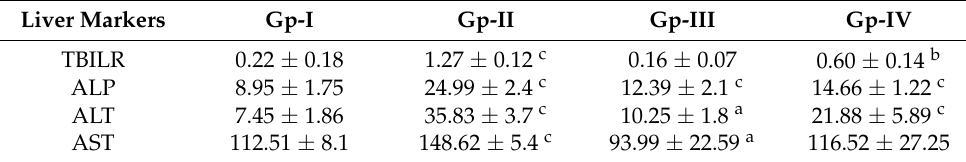
Table 2. Serum-liver-function parameters for each animal group used in this